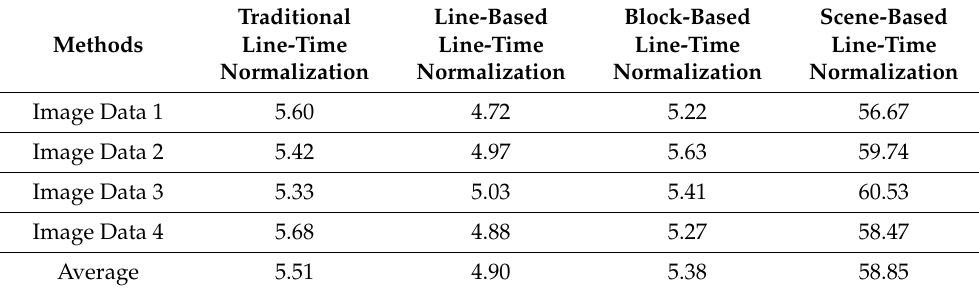
Table 4. Time consumption of different stitching methods (seconds).